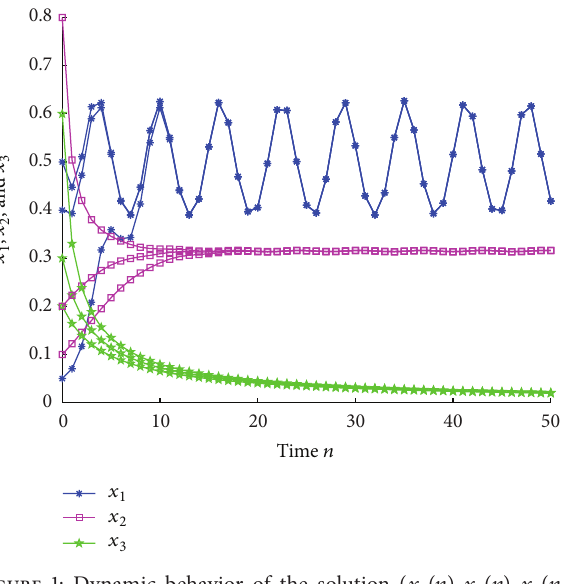
Figure 1: Dynamic behavior of the solution (𝑥 1 (𝑛),𝑥 2 (𝑛),𝑥 3 (𝑛)) to system (95) with the initial conditions (𝑥 1 (0),𝑥 2 (0),𝑥 3 (0)) = (0.05, 0.1, 0.2),(0.5, 0.8, 0.3) and (0.4, 0.2, 0.6) ,